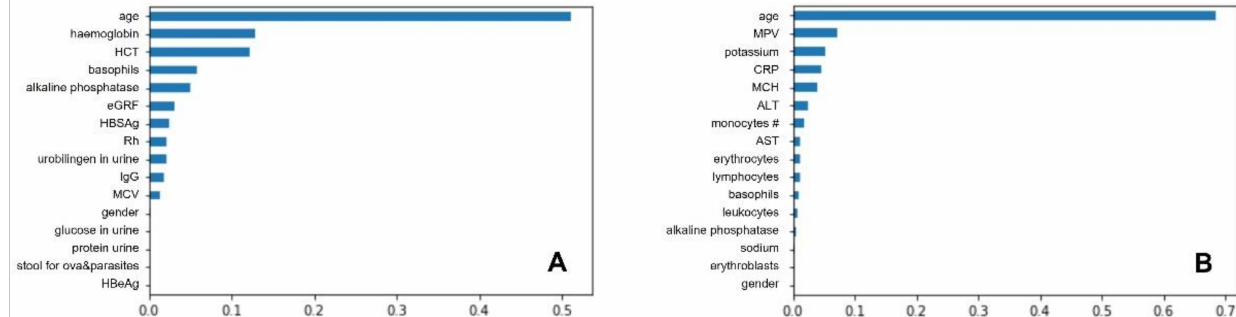
Figure 2. Gradient boosting classifier features importance for ulcerative colitis ( A ) and Crohn’s disease ( B ). Abbreviations for ( A ): HCT, hematocrit; eGFR, estimated glomerular filtration rate; HBsAg, Hepatitis B s Antigen; IgG, immunoglobulin G; MCV, mean corpuscular volume; HBeAg, Hepatitis B e Antigen; Abbreviations ( B ): MPV, mean platelet volume; CRP, C-reactive protein; MCH, mean corpuscular haemoglobin; ALT, alanine aminotransferase; AST, aspartate